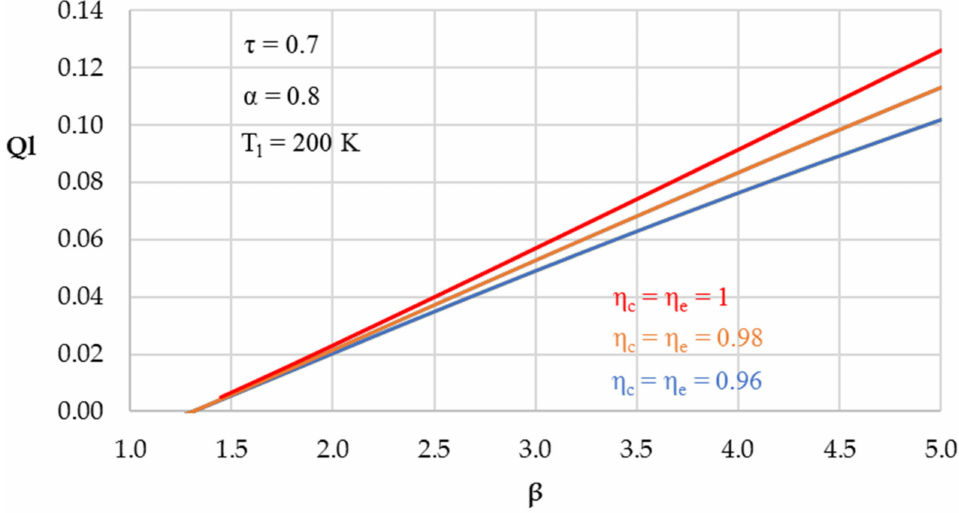
Figure 6. Correlation of the dimensionless refrigeration load Q l with the ratio between the magnetic fields β for various values of η e = η c , by fixing τ = 0.7, α = 0.8 and T l = 200